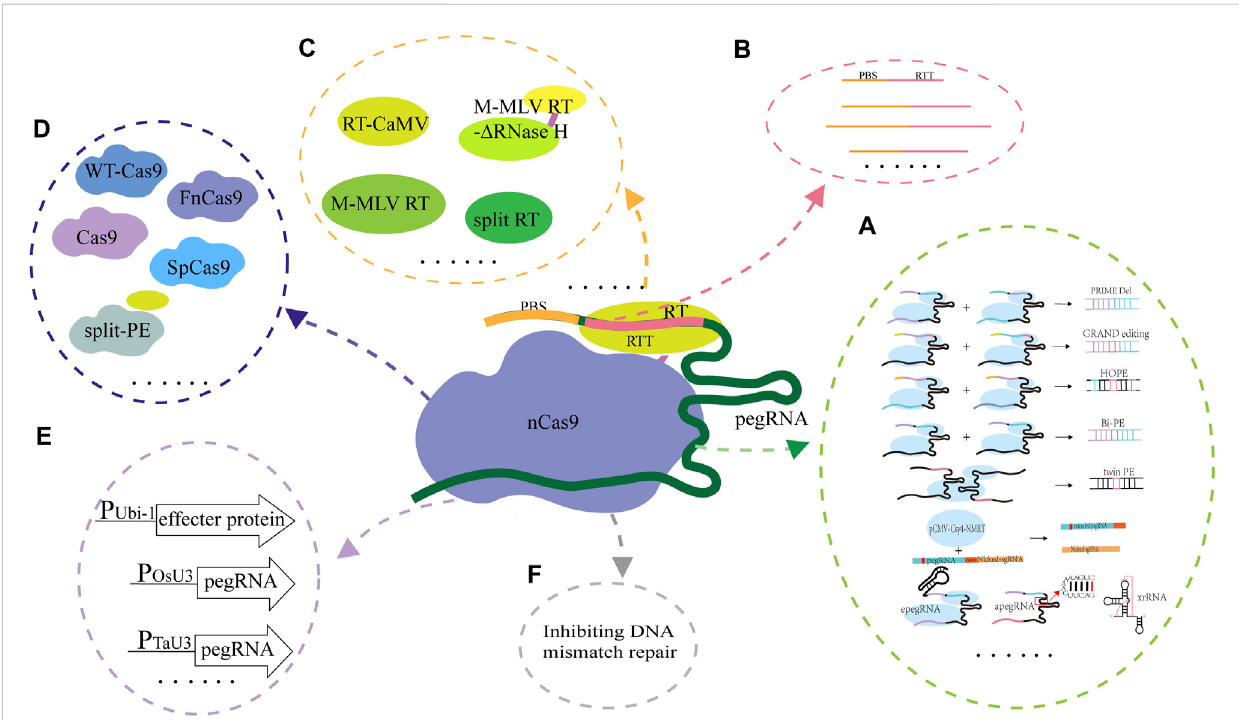
FIGURE 3 StrategiesusedforoptimizationofthePEsystem. (A) ,OptimizationofpegRNA.InPRIME-Del,apairofpegRNAsforoppositeDNAstrandswereused for accurately editing the targets; In GRAND, a pair of pegRNAs with different but complementary RTT and target DNA sequences were used; In HOPE, twopegRNAswhichcontainhomologous3 ′ terminalsandusedfortargetingDNAdoublestrandsweredesignedandused;InBi-PE,anicksgRNAnearthe pegRNA template sequence was used; In twinPE, a prime editor protein and two pegRNAs were used; In ePE, the pegRNA skeleton was optimized through fusing the nicking sgRNA and pegRNA in one transcriptional unit; In epegRNA, the pegRNA (epegRNAs) was engineered based on integration of the structured RNA motifs into the 3 ′ end of pegRNAs; (B) , Changing the lengths of PBS and RTT. The ratio of targeted editing to off-target editing was signi fi cantly affected by the length of RTtemplate, but didnot change with the length of PBS or the location of nicking sgRNA; (C) , Optimization of RT. In the ePPE system, the RNase H domain in M-MLV RT was deleted and a virus nucleocapsid protein (NC) was added; In the PPE system, the engineered M-MLV-RT was replaced by CaMV-RT from cauli fl ower mosaic virus and reverse transcriptase derived RT (RT retron) from E. coli BL21; In Spilt-PE, the fusion effecter protein was split into two parts including split nSpCas9 and MMLV-RT; (D) , Optimization of Cas9 for expanding its editing scope. The PE2 variants (PE2-vqr, PE2-vrqr, PE2-vrer, PE2-ng, PE2-spg, and PE2-spry) could recognize the different PAM sequences; (E) , Optimization of the promoters for expressing the effecter protein gene and pegRNA. In PPE, the ubiquitin-1 gene ( Ubi-1 ) promoter from maize was used to drive the expression of theeffecter protein coding gene after its codon was optimized according to the codon preference of rice, the osu3 promoter from rice (or the TaU6 promoter from wheat) and the TaU3 promoter from wheat were used to drive the transcription of pegRNA and the nicking sgRNA; (F) , OptimizationofthePEsystemthrough inhibiting theDNAmismatch repair. The PE4and PE5systems wereconstructed throughtransientexpressingthe DNA mismatch inhibitor protein MLH1dn coding gene; PEmax was constructed by changing RT codon, mutating SpCas9 and optimizing the NLS sequence. The ePE3max system consists of PEmax protein, an epegRNA with evopreQ1 and a nicking sgRNA, and the ePE5max system consists of ePE3max and a dominant negative OsMLH1 variant that inhibits